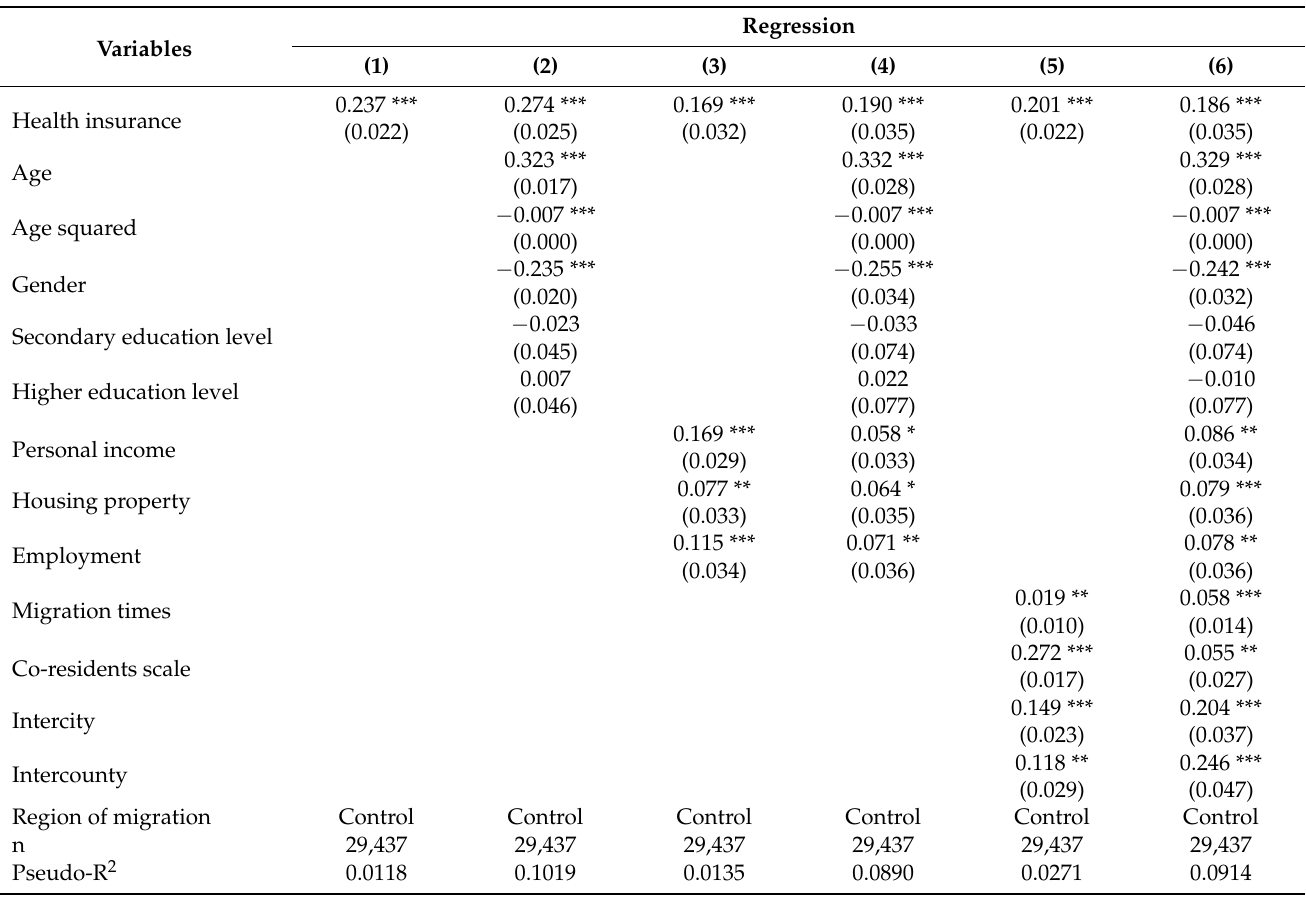
Table 2. Logit regression results of the impact of Health insurance on fertility intention of China’s rural floating